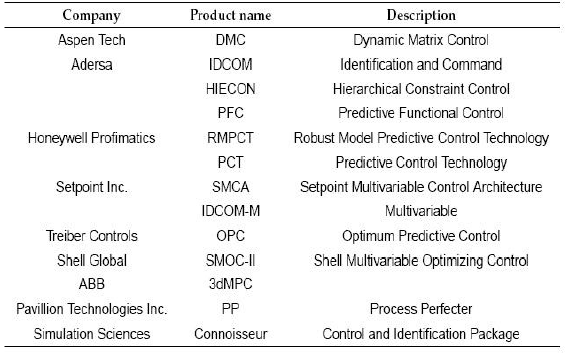
Fig. 2: Industrial technology implementing